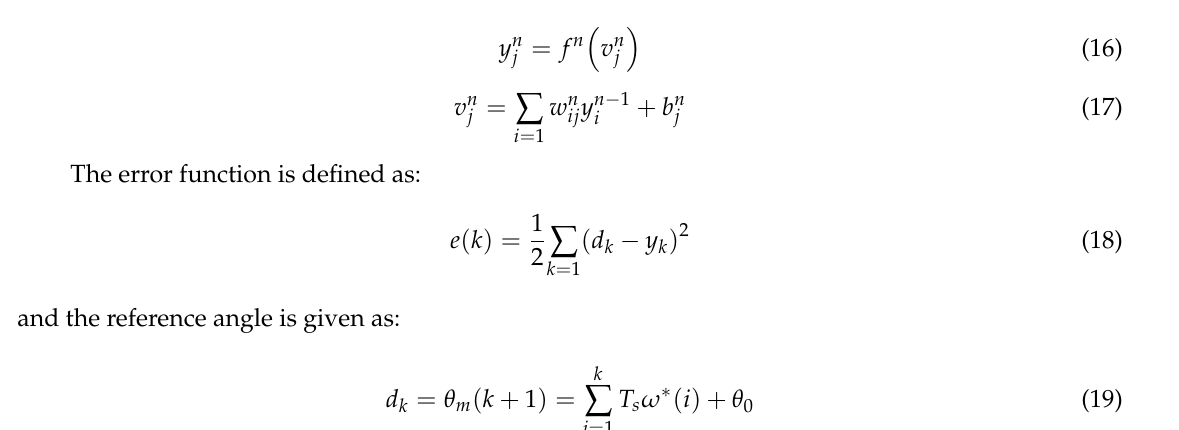
Figure 3. The artificial neural network.